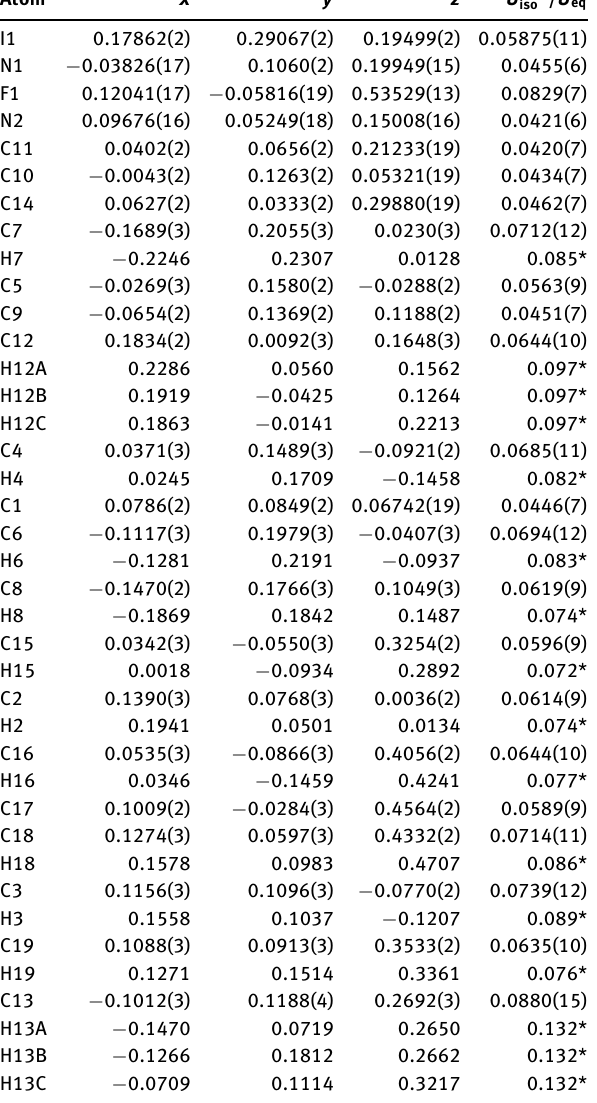
Table 2: Fractional atomic coordinates and isotropic or equivalent isotropic displacement parameters (Å 2